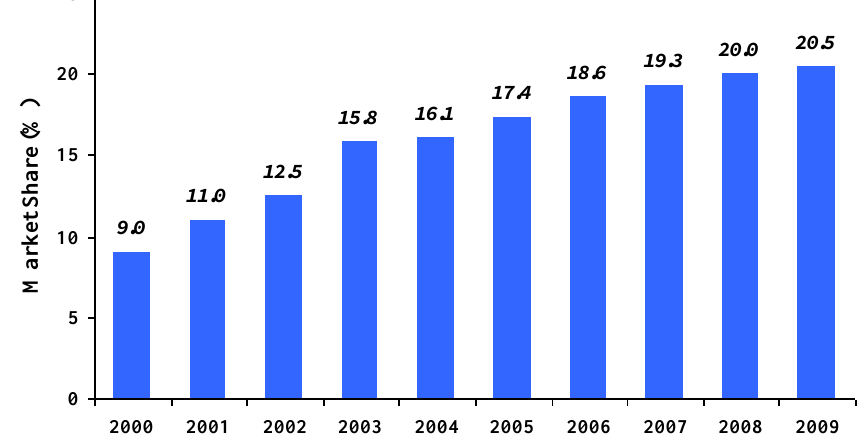
Figure 1. Menthol share of the Japanese cigarette market (2000-2009) ; data from